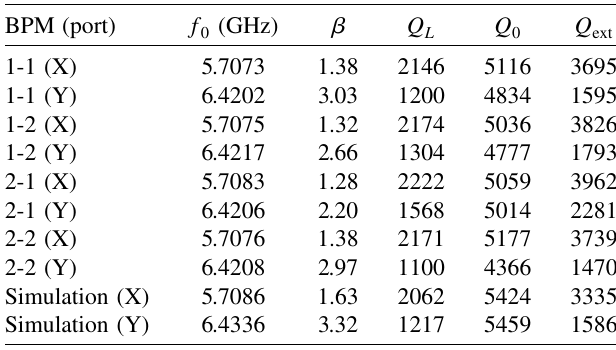
TABLE I. The rf measurement results of cavity BPMs. (Since there are two blocks and each contains two cavities, they are identified as block_no.-cavity_no.).